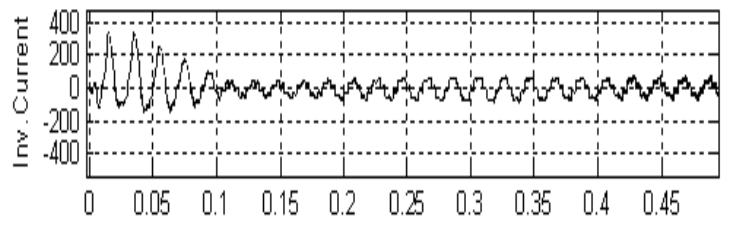
Figure 9b. “Inverter Current under dynamic